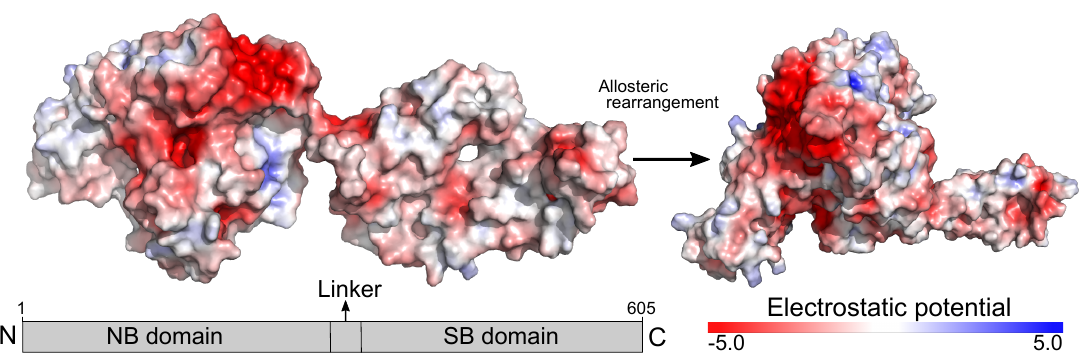
Figure 1. Overview of the allosteric rearrangement and electrostatic potential of HSP70. The protein structures (IDs 2KHO and 4B9Q) were retrieved from the Protein Data Bank and depicted to show the allosteric rearrangement [ADP ( left ) and ATP ( right ) bound states] and electrostatic potential of HSP70. The electrostatic potential was computed using the Adaptive Poisson-Boltzmann Solver (APBS) electrostatics plugin in the software PyMol (version 2.2.0) and it is shown in a red (negative) to blue (positive)